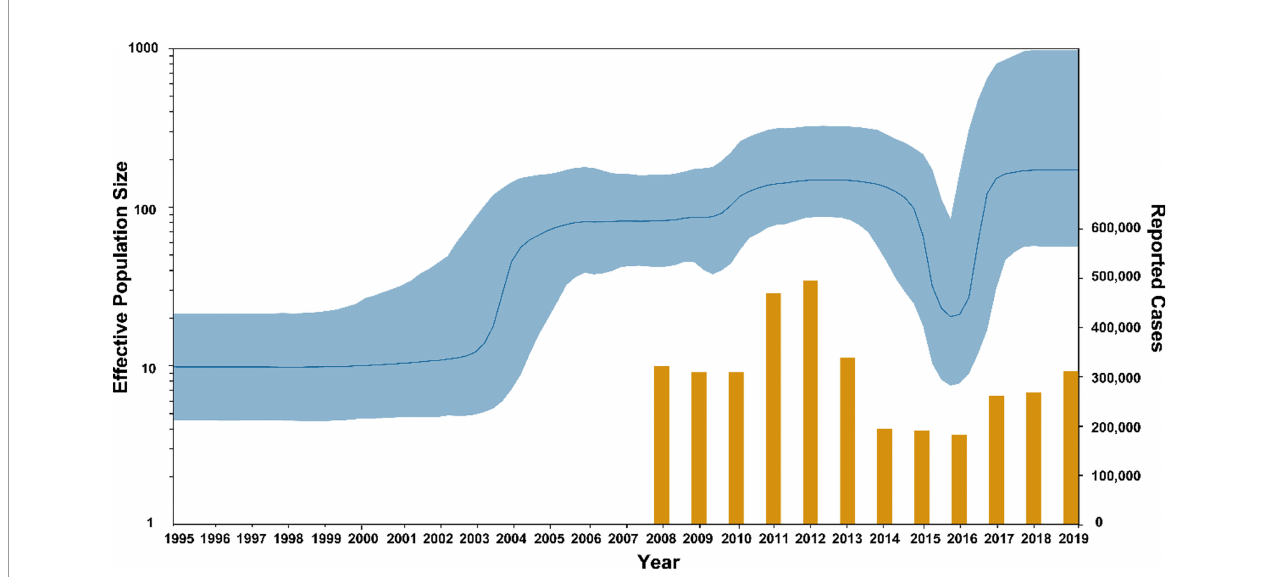
FIGURE 6 | The population dynamics of MuV genotype F circulated in China. Yellow bars indicate the number of mumps cases reported by National Noti fi able Diseases Reporting